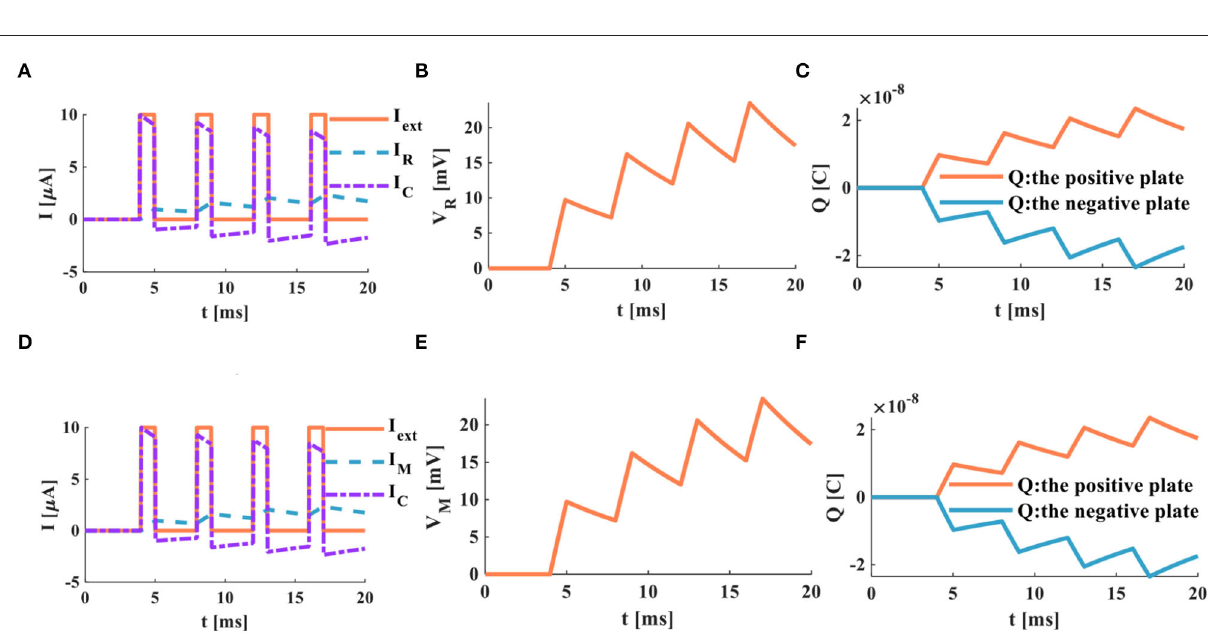
stimulus, the resistor (memristor), and capacitor values are the main factors to affect the production of the action